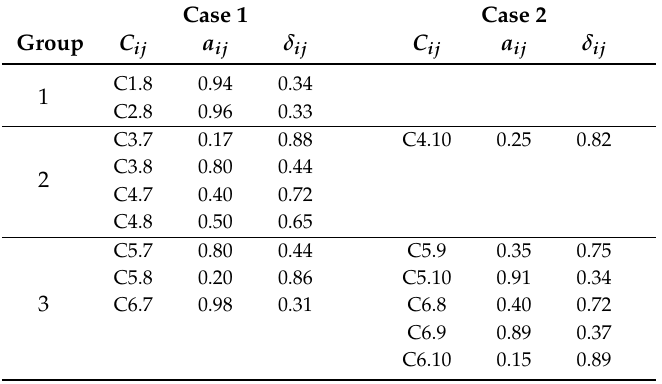
Table 6. Shaded area and shading ratio for monocrystalline PV module Tenesol TE-2200.